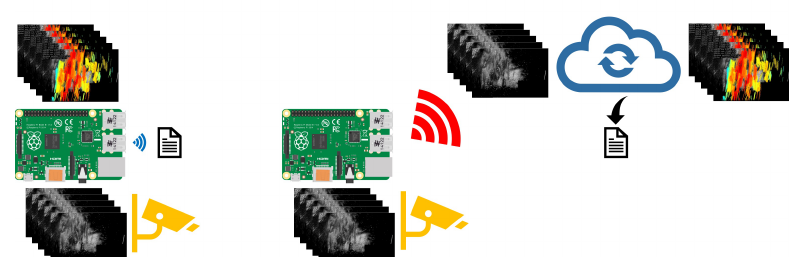
Figure 1. ( Left ) In situ processing with an embedded system as proposed in this work, ( Right ) offload cloud processing strategy deployed by conventional solutions. The latter requires a high-bandwidth data connection, not always available in remote monitored places, to transfer the image stream gathered in the field to a remote location for deferred